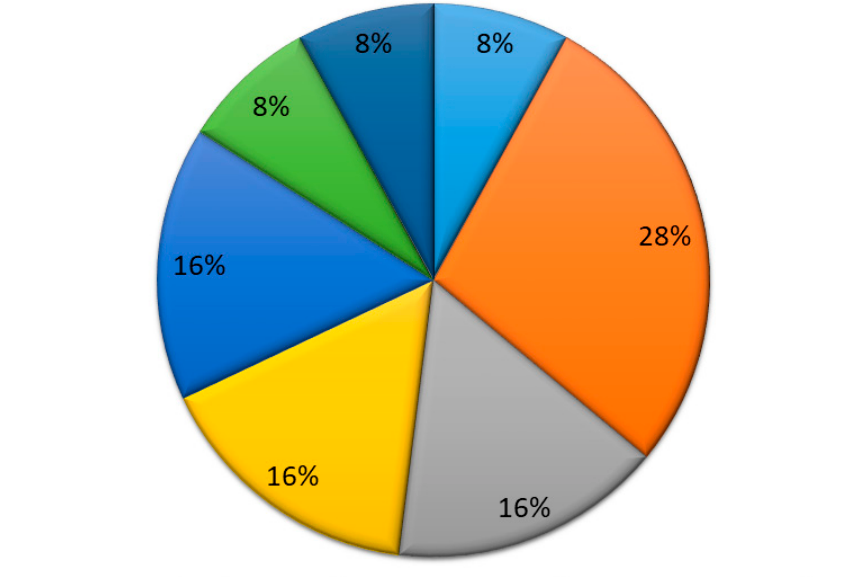
Figure 3. Selected studies repository ratio.